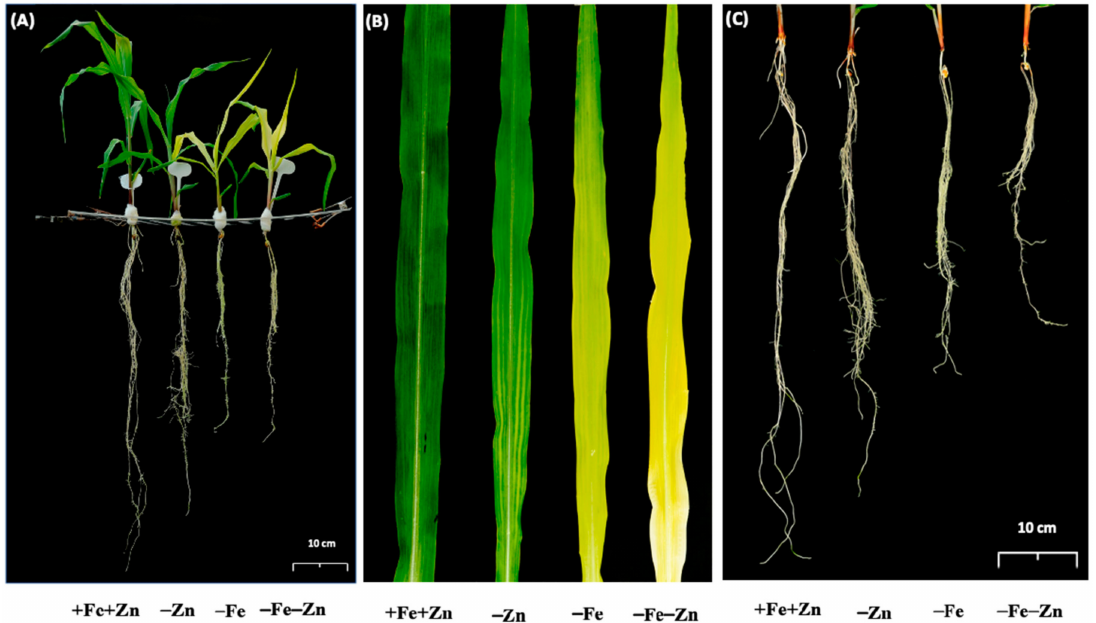
Figure 1. Phenotypic expression of 19 days-old maize SKV616 seedlings in response to 12 days